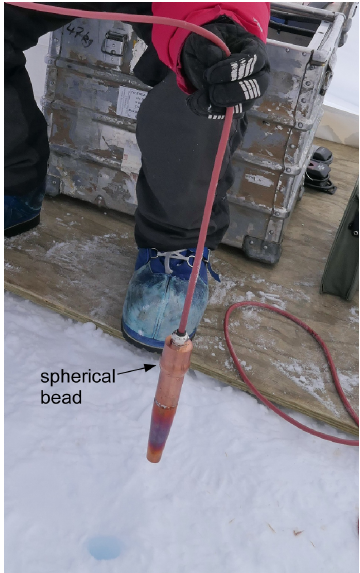
Figure 2. Heated copper “plumb bob” for melting and glazing the first 6m of the firn